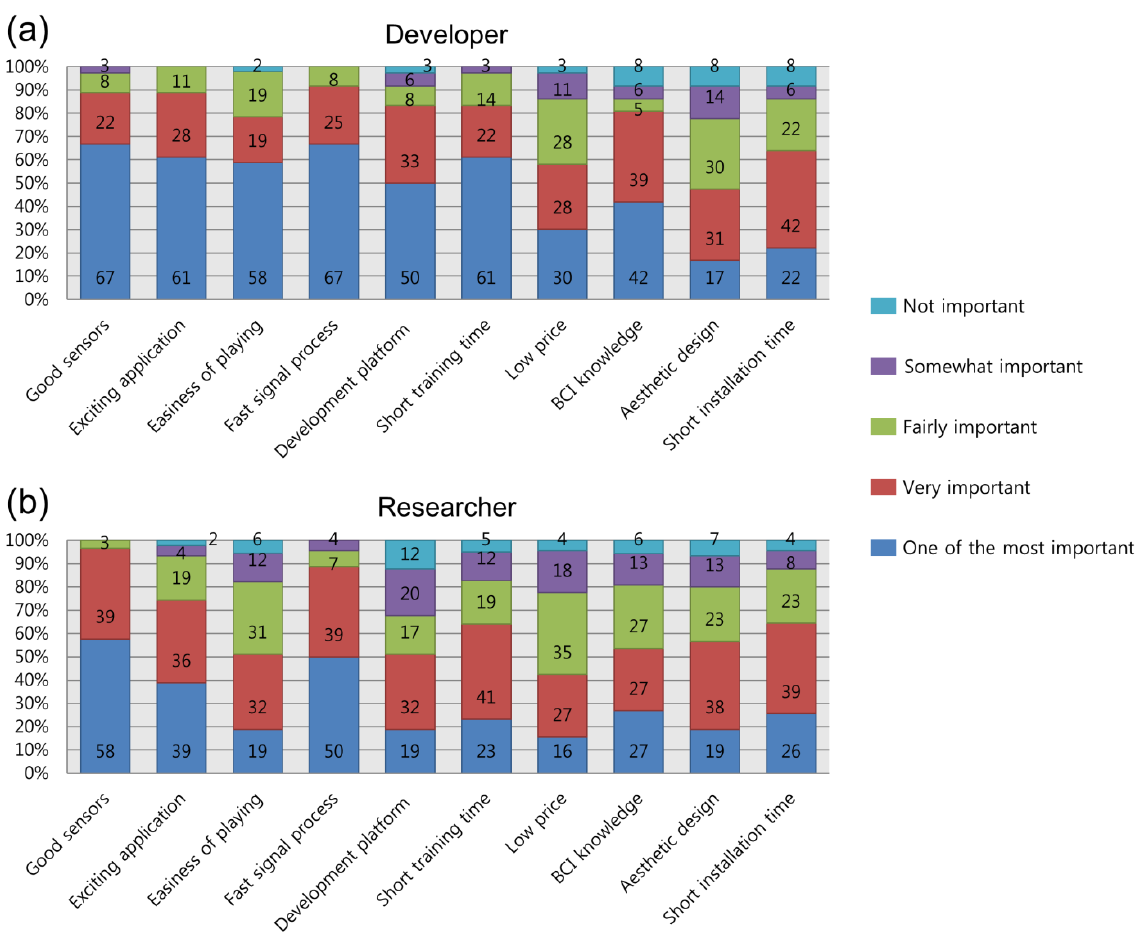
Figure 11. Importance of elements in BCI games: opinions from ( a ) developers and ( b )